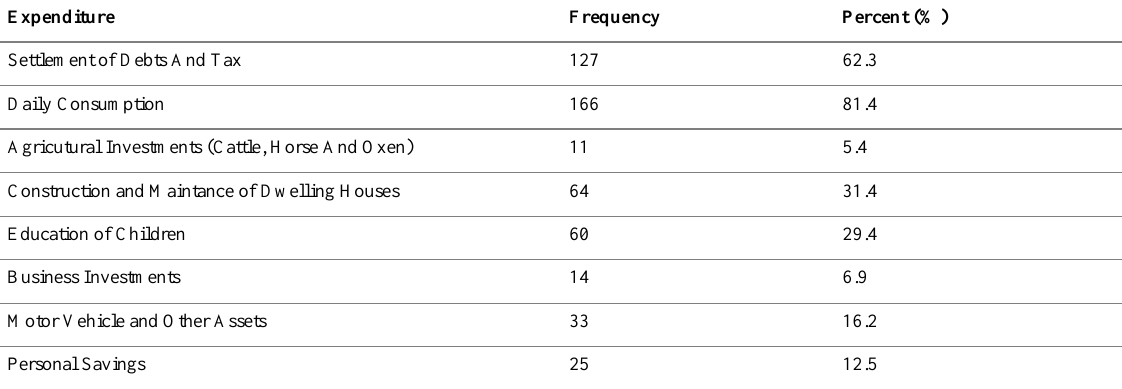
Table 7. Expenditure for Remittances from Urban